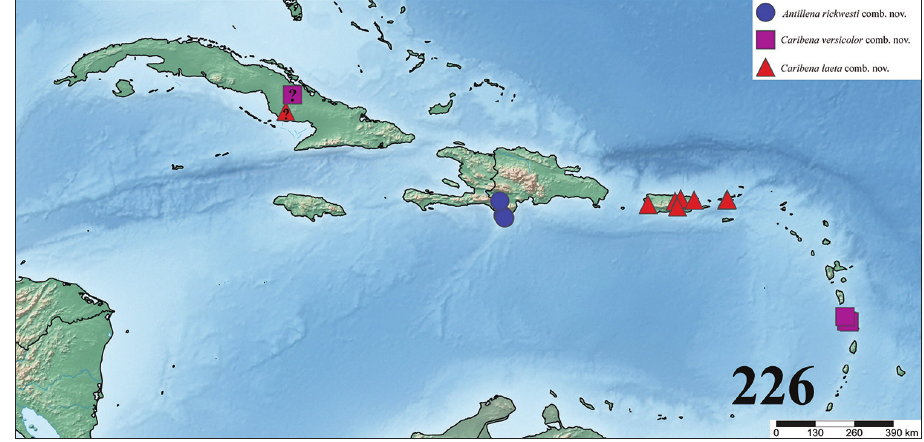
Figure 226. Map showing records of Caribena gen. n. and Antillena gen. n. ? = uncertain